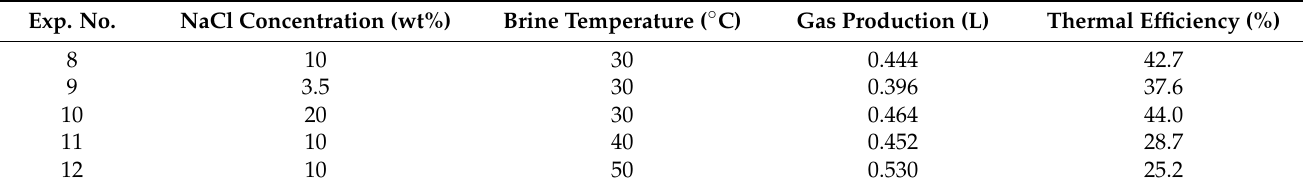
Table 3. The initial experimental conditions and the results of CH 4 production by brine